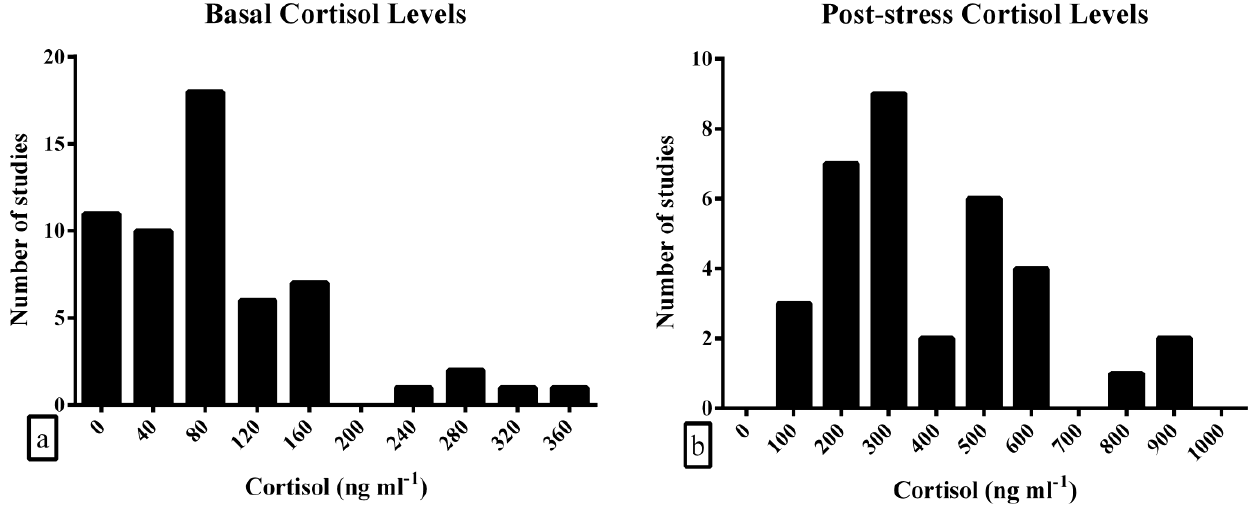
Figure 2. Frequency distribution of meta-analysis data for ( a ) basal and ( b ) post-stress cortisol lev- els.